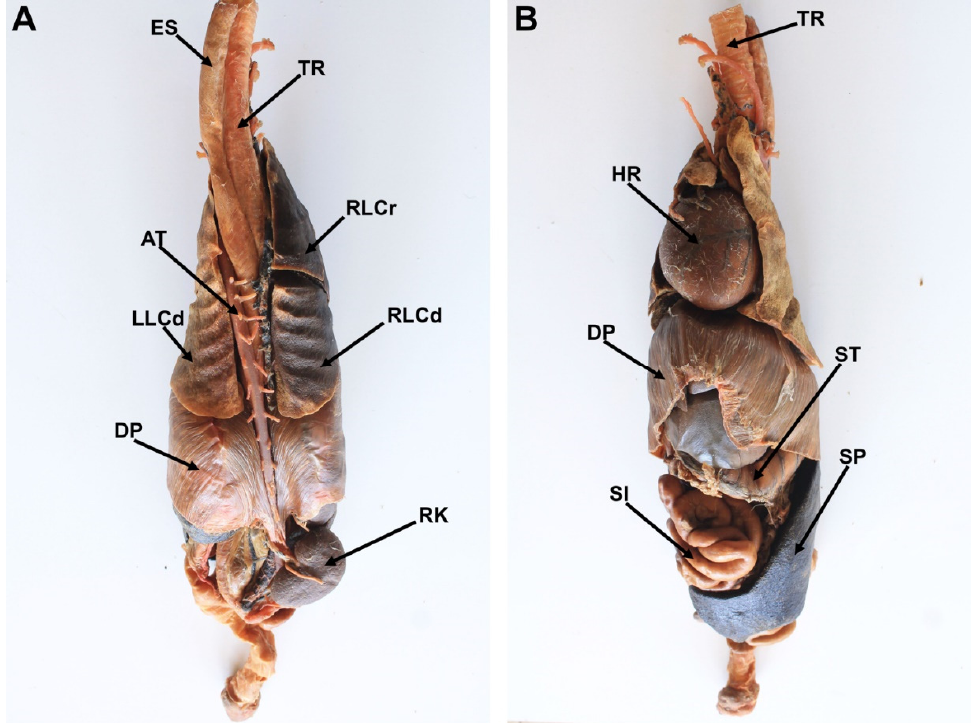
Figure 2. Photographs of the right side of a canine heart preserved and stained by the modified Elnady technique. ( A ) Left side ( facies auricularis ) of the heart. ( B ) Right side ( facies atrialis ) of the heart. LA: Left auricle; RAt: Right atrium; PT: pulmonary trunk, RV: Right ventricle; LV: Left ventricle. The ventricles were colored (red) by applying dying previous to the dehydration process. The coronary veins were injected with blue latex.